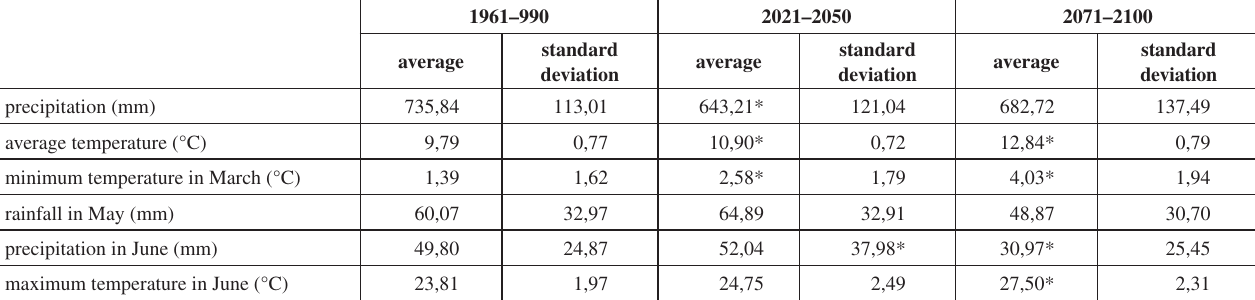
Table 5. Some climatic parameters in the Érd subregion (* means the signifi cant difference compared to the base period of